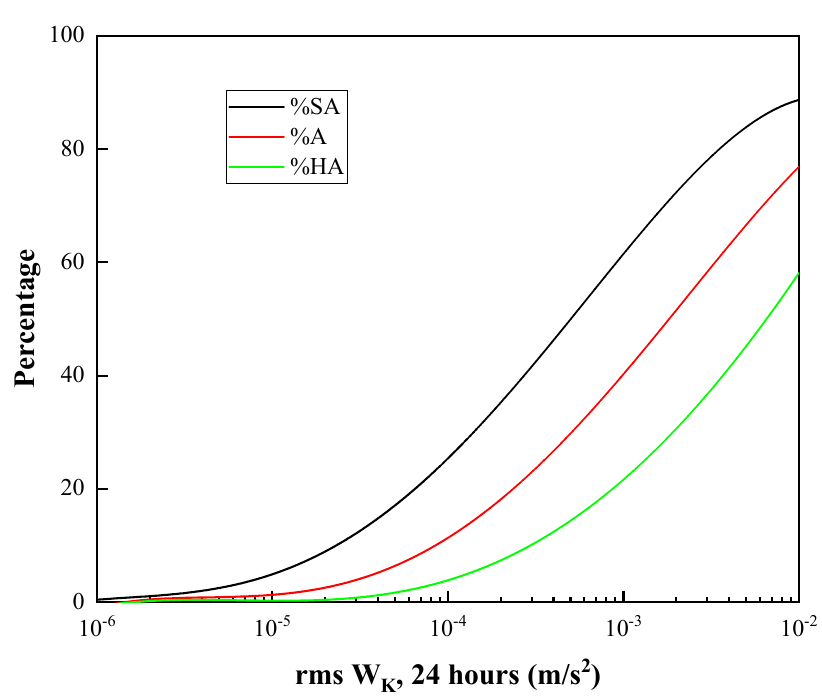
w Figure 15. Annoyance rate for the rms ( w k k -weighted root-mean-square acceleration over the entire